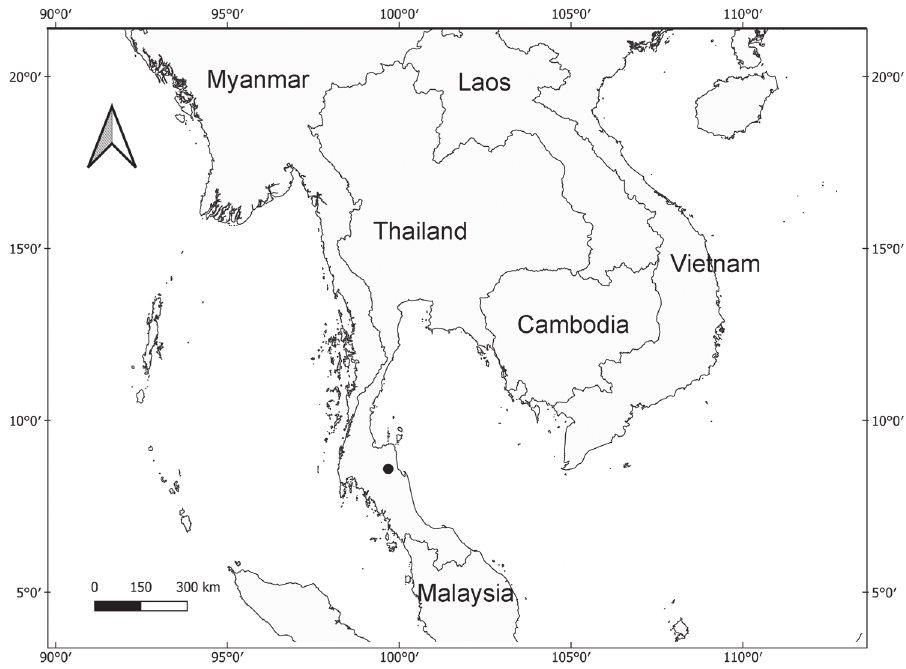
Figure 3. Type locality of Corybas papillatus Inuthai, Chantanaorr. & Suddee ( •